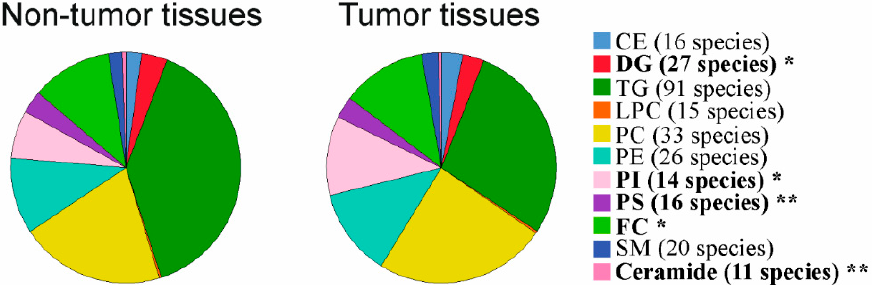
Figure 1. Lipidomic profiling in non-tumorous and tumor tissues of patients with chronic viral infection. Cholesteryl ester (CE), diacylglycerol (DG), triacylglycerol (TG), lysophosphatidylcholine (LPC), phosphatidylcholine (PC), phosphatidylethanolamine (PE), phosphatidylinositol (PI), phos- phatidylserine (PS), free cholesterol (FC), sphingomyelin (SM) and ceramide levels in non-tumorous and tumor tissues of patients with chronic viral infection are shown. Number of species detected are given in brackets. Significant different lipid classes are in bold. * p < 0.05, ** p < 0.01 (Mann- Whitney